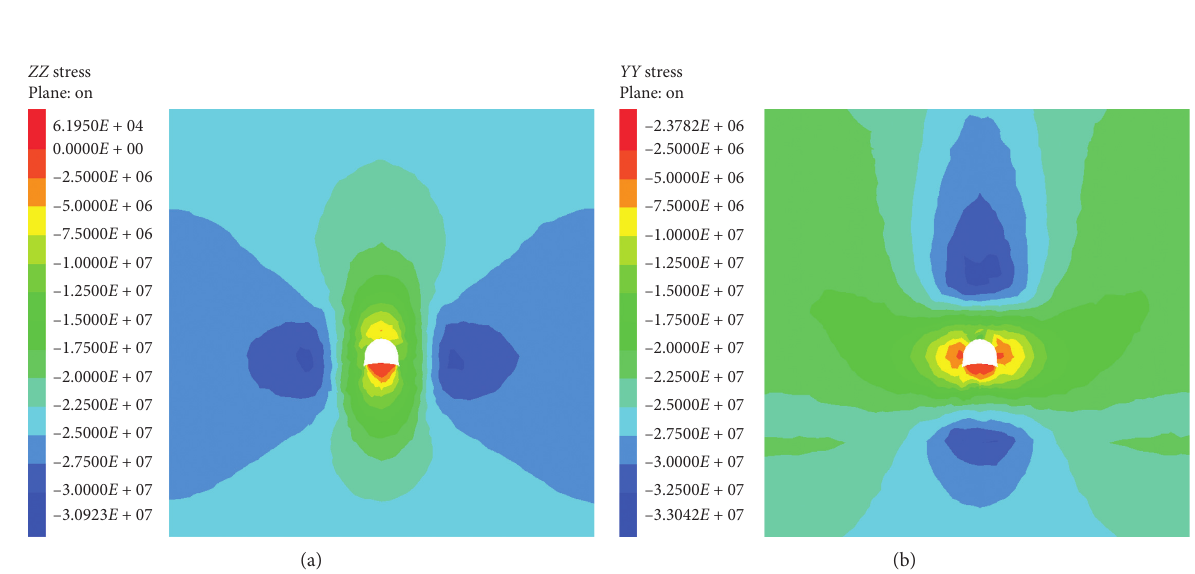
Figure 6: Stress field distribution of surrounding rock under original support (unit: Pa): (a) horizontal stress; (b) vertical stress.